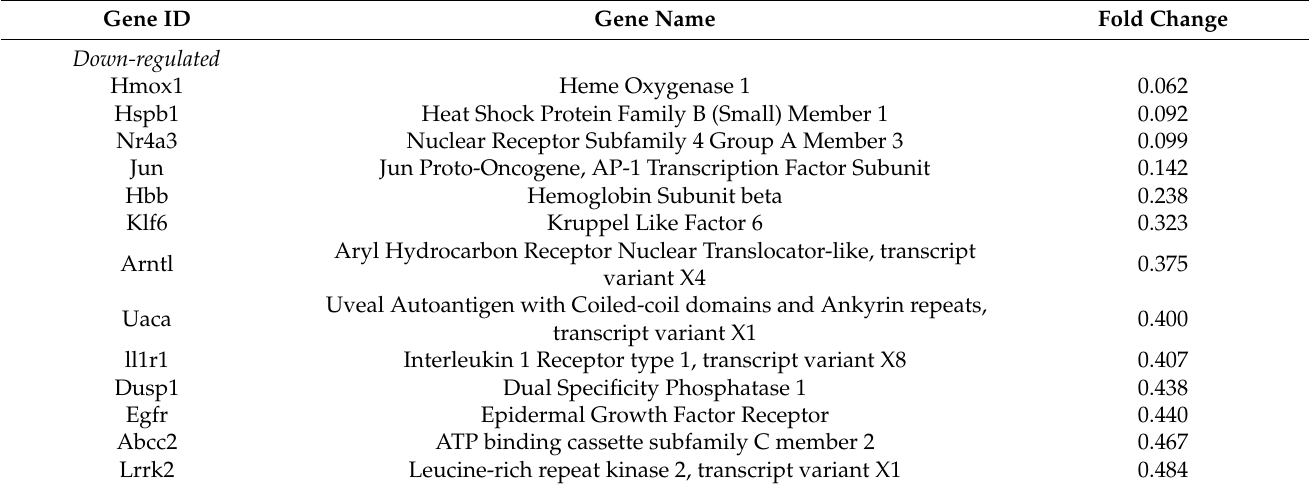
Table 3. Response to Oxidative-Stress-Related Gene Expression in the NaCl vs. HMLS Group.